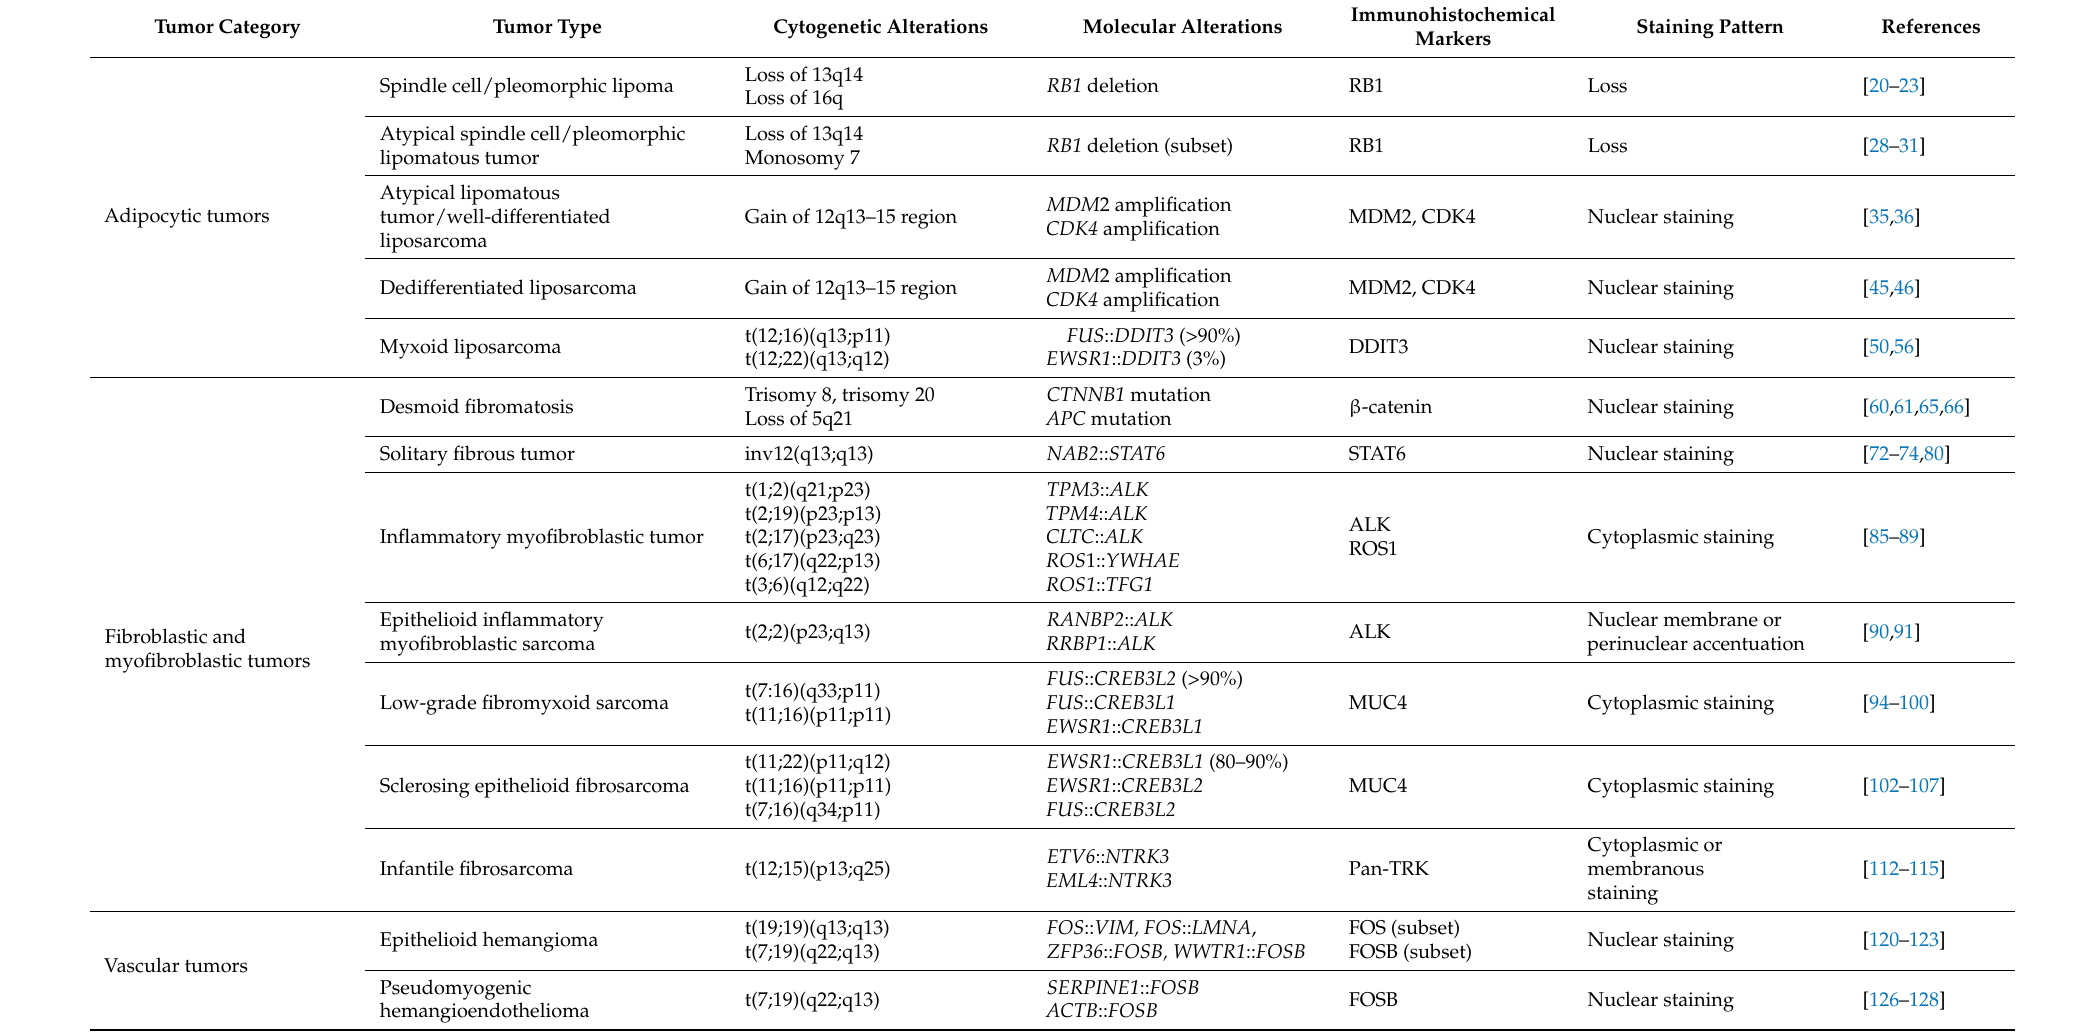
Table 1. Recently described molecular genetic alterations and immunohistochemical markers in selected soft tissue